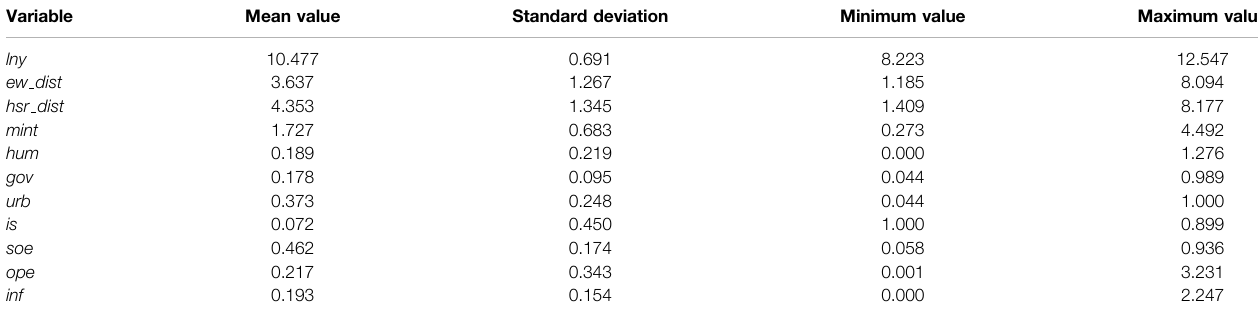
TABLE 1 | Descriptive statistics of variables. Variable